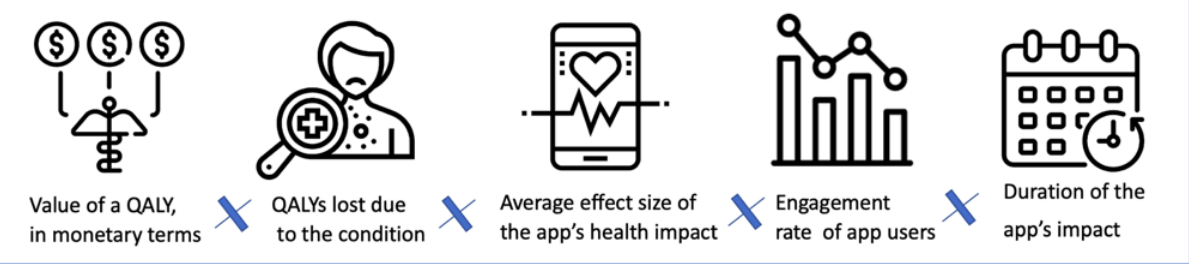
Figure 1. Methodology for estimating the economic value of the clinical benefits of digital health apps. Economic value of an app’s clinical benefits = country-specific monetary value of a QALY * QALYs lost due to the condition * engagement rate of app users * average effect size of the app’s health impact * duration of the app’s impact before